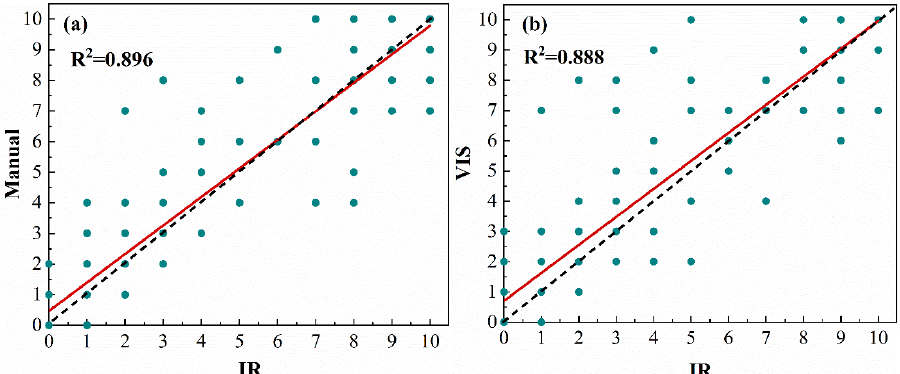
Figure 8. Correlation of infrared cloud fraction estimation with ( a ) manual and ( b ) visible observation results. The dotted line in the figure represents the 1:1 line, and the solid line represents the fitting line. On the other hand, in order to make the discrepant cases clearer, the differences be- tween the infrared cloud fraction and the visible and the manual results were counted, as shown in Figure 9. The percentages of the difference of the IR-Manual within zero-ten and one-ten oktas are 64.3% and 16.8%, respectively. Meanwhile, the percentages of the differ- ence of IR-VIS within zero-ten and one-ten oktas are 62.8% and 19.6%, respectively. The percentage of the differences of IR-Manual less than three-ten oktas is 91.2%, and it is 88.3% between the infrared and the visible results. This indicates that most of the results of IR-Manual and IR-VIS are not large, but there are still differences between the infrared and the other two manners. For the purpose of optimizing the ASC-200 system in future research, it is important to analyze the cases with large differences between infrared and visible cloud fractions. Figure 9. Distribution of cloud fraction difference between the infrared and visible (IR-VIS), and the infrared and manual observations (IR-Manual). One of the typical cases with a large difference between the infrared and the visible is shown in Figure 10. Figure 10(a1) and 10(b1) show the visible and TIR cloud images, respectively, and there is thin cirrus (the area marked with the red boxes) in the sky. Fig- ures 10(a2) and (b2) are the visible and the infrared clouds detection results, respectively. Using the SegCloud recognition model proposed in our previous study [40], the visible